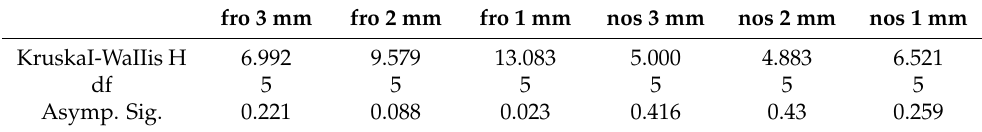
Table 2. Kruskal–Wallis Test demonstrating no significative differences between operators.